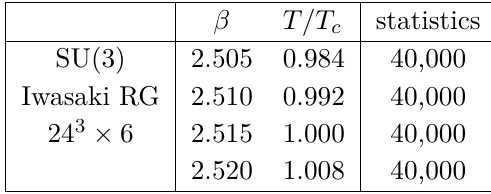
Table 1 . The lattice parameters of the ensembles and other